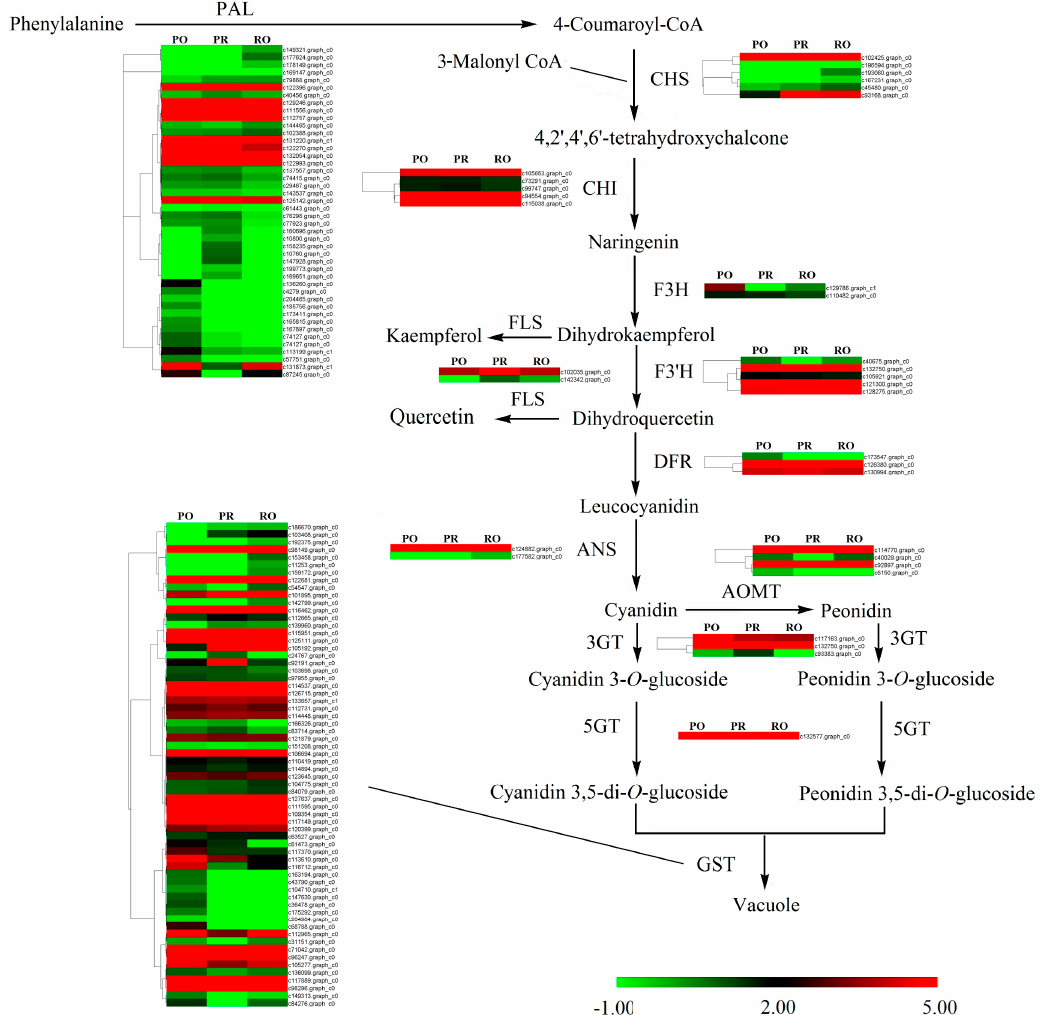
Figure 6. A detailed schematic of anthocyanin metabolism related to flower pigmentation in PO, PR and RO. Enzyme names and expression patterns are indicated beside each step. The expression pattern of each gene is shown in a heatmap. The color scale represents log2 transformed FPKM values. Green indicates low expression, and red indicates high expression.